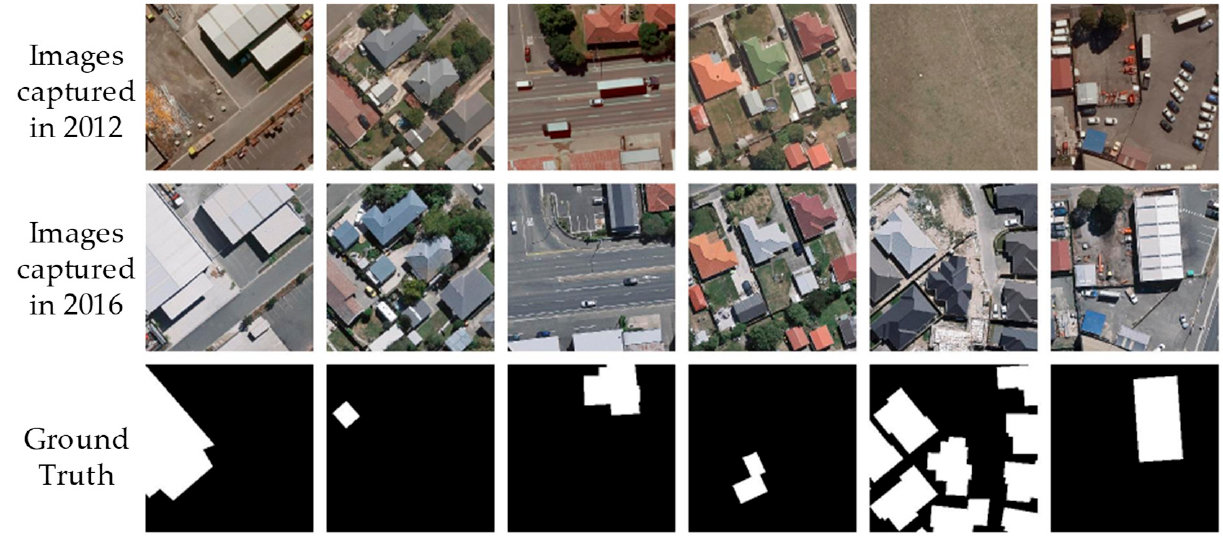
Figure 2. Illustrations of bitemporal aerial images from the WHUCD dataset.